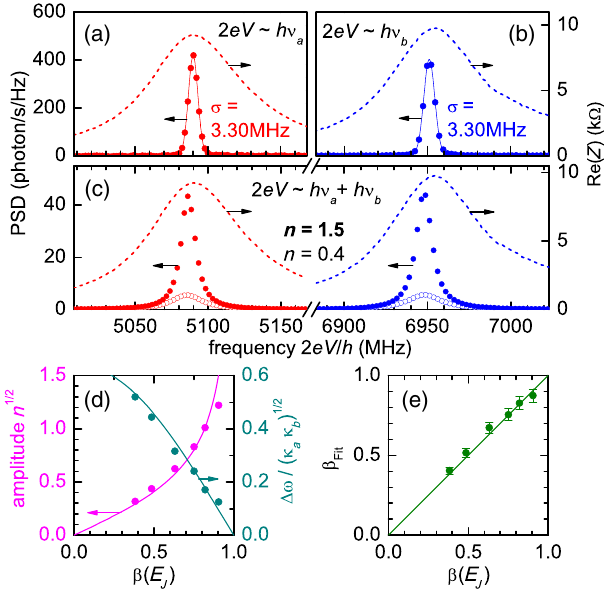
FIG. 3. Characterization of the emission. (a),(b) In situ mea- sured real part of the impedance across the Josephson element (dashed lines, right-hand axis), and example of measured (dots) and Gaussian-fitted (lines) power spectral densities (left-hand axis) recorded separately around 2 eV ¼ h ν (a) and 2 eV ¼ h ν a b 0 . 34 and n 0 . 39 , respectively. (b) at small E yielding n J a ¼ b ¼ The emission linewidth results from the voltage-noise-induced 2 eV=h Þ of the Josephson frequency. The distribution p ð ν J ¼ corresponding standard deviation σ is the same for both lines but drifts slowly back and forth over hours and days. (c) Same real part of the impedance (dashed lines, right-hand axis) as in (a), and examples of emitted power spectral densities (PSDs, left-hand h ν scales) measured at 2 eV ¼ h ν and driving strengths β ¼ a þ b 0 . 67 (open circles)and β ¼ 0 . 9 (solid dots) corresponding to average photon numbers n ¼ 0 . 4 and n ¼ 1 . 5 . (d) Measured (symbols) reduced intraresonator amplitude (magenta, left-hand scale) and emission width (dark cyan, right-hand scale) of the PSDs of Fig. SM2 [32], compared to the corresponding analytical expressions (lines) known for Hamiltonian (5). (e) Dimensionless pumping strength fitted from the same PSD versus the calibrated